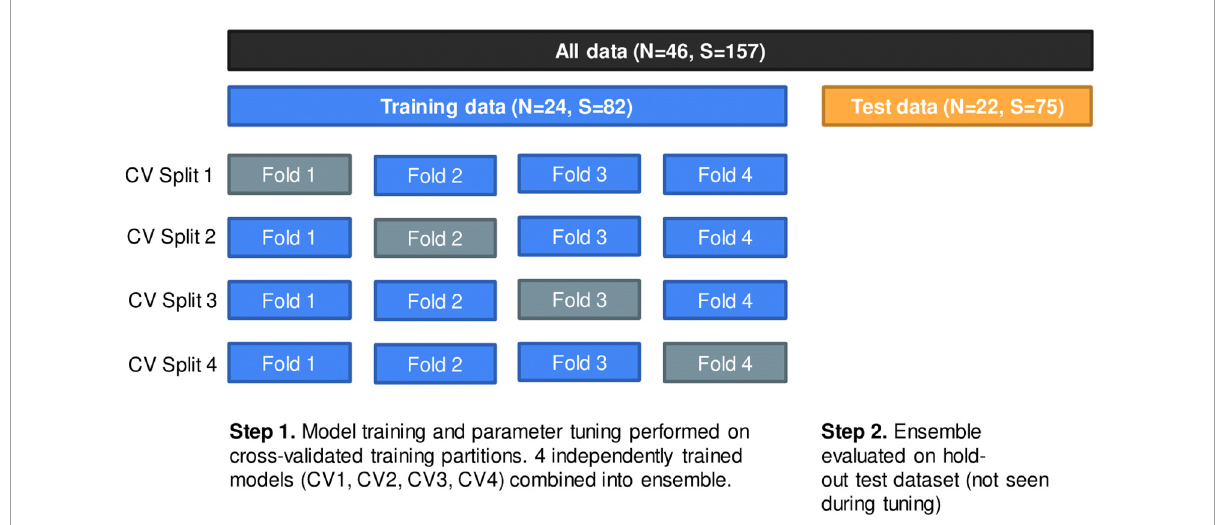
FIGURE2 Data partition using group fourfold cross-validation (CV) method. Within training data, each split represents one independently trained model. Models were evaluated on a hold-out test dataset of 22 patients (75